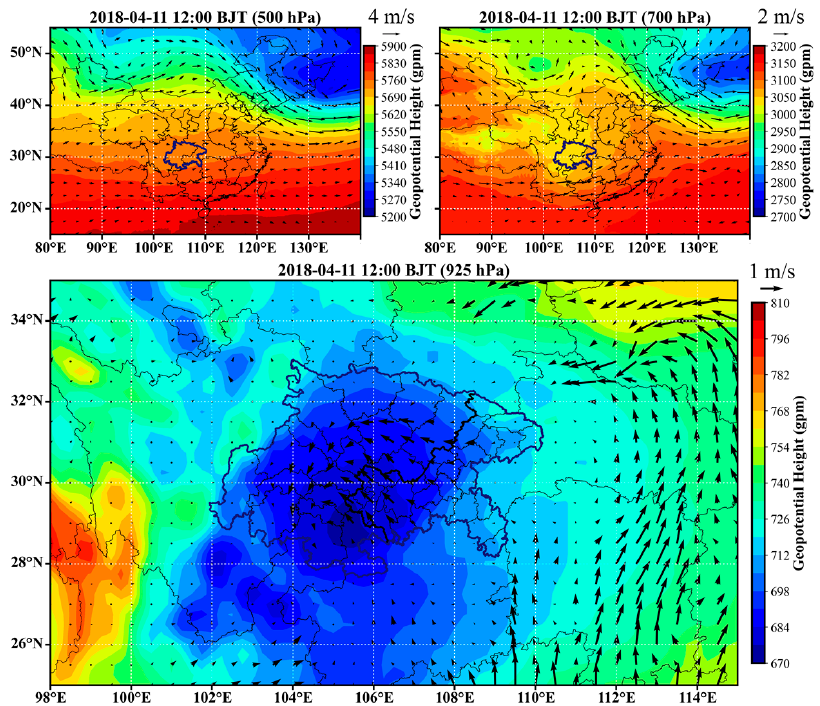
Figure 7. Typical circulation features in spring. The arrows represent horizontal wind vectors.